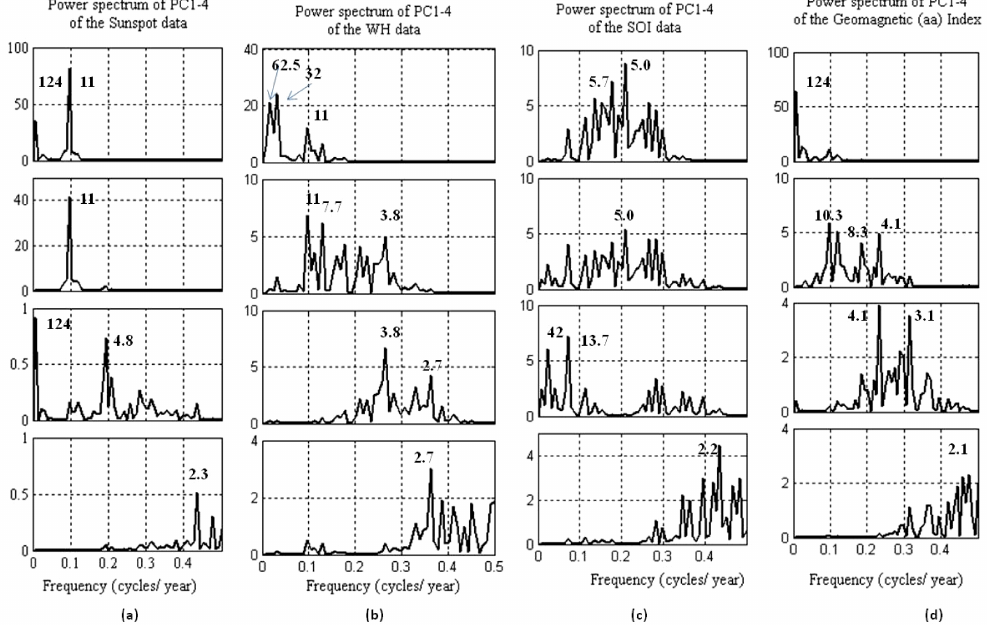
Figure 3. Power spectra of the first four principal component (PCs) (PCs 1–4 shown in Fig. 2) for all the data sets with their significant periodicities at 124, 11, 4 and 2.8 years indicated in bold